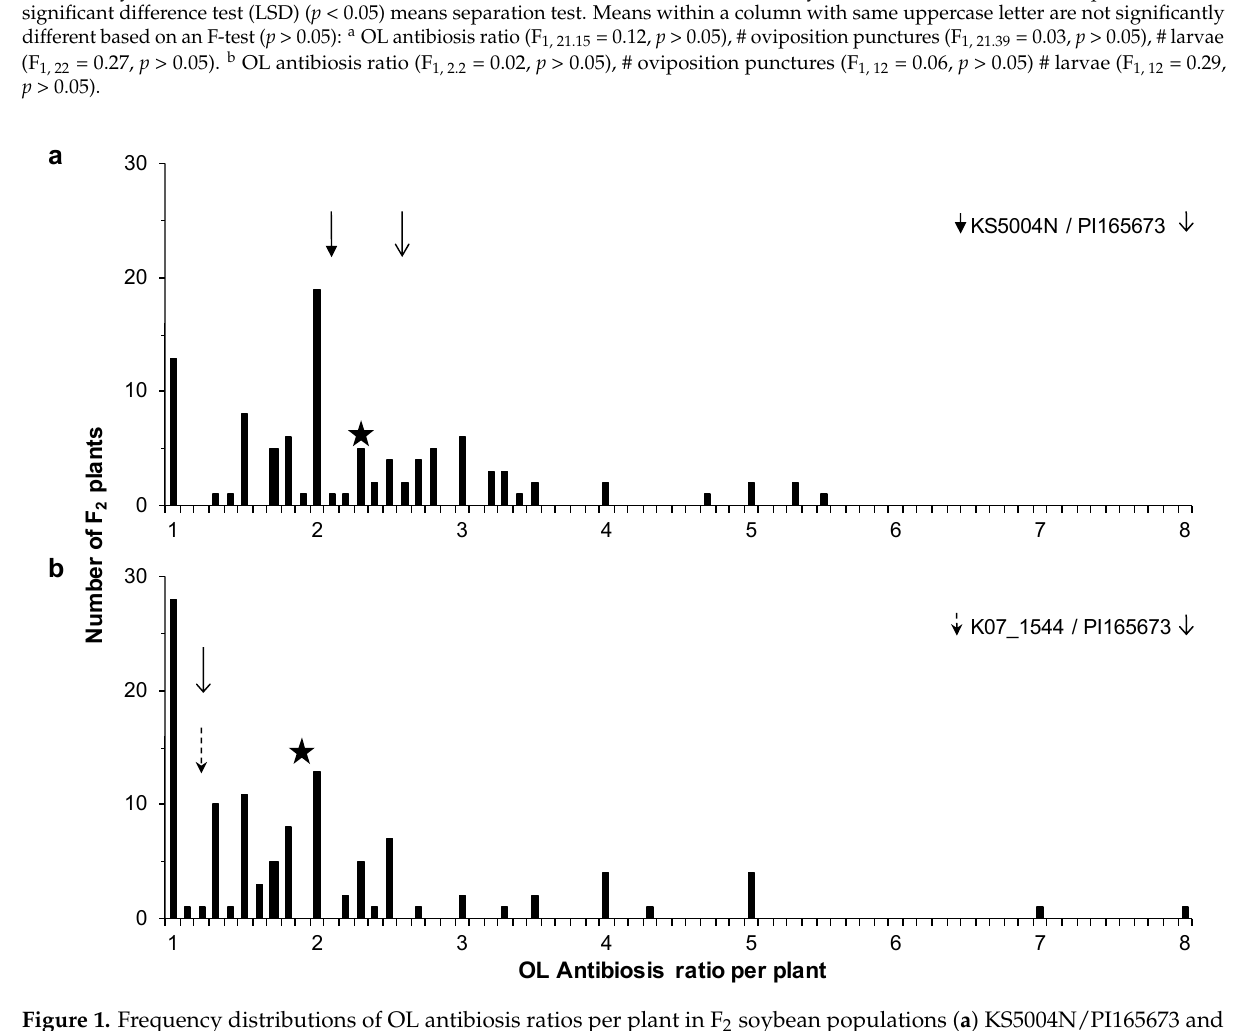
OL antibiosis ratio = (number of oviposition punctures/number of larvae), SEM: Standard Error of Mean; n : number of plants. Means followed by a different lower-case letter within a column for each cross are statistically different based on a Fisher’s protected least significant difference test (LSD) ( p < 0.05) means separation test. Means within a column with same uppercase letter are not significantly different based on an F-test ( p > 0.05): a OL antibiosis ratio (F 1, 21.15 = 0.12, p > 0.05), # oviposition punctures (F 1, 21.39 = 0.03, p > 0.05), # larvae (F 1, 22 = 0.27, p > 0.05). b OL antibiosis ratio (F 1, 2.2 = 0.02, p >